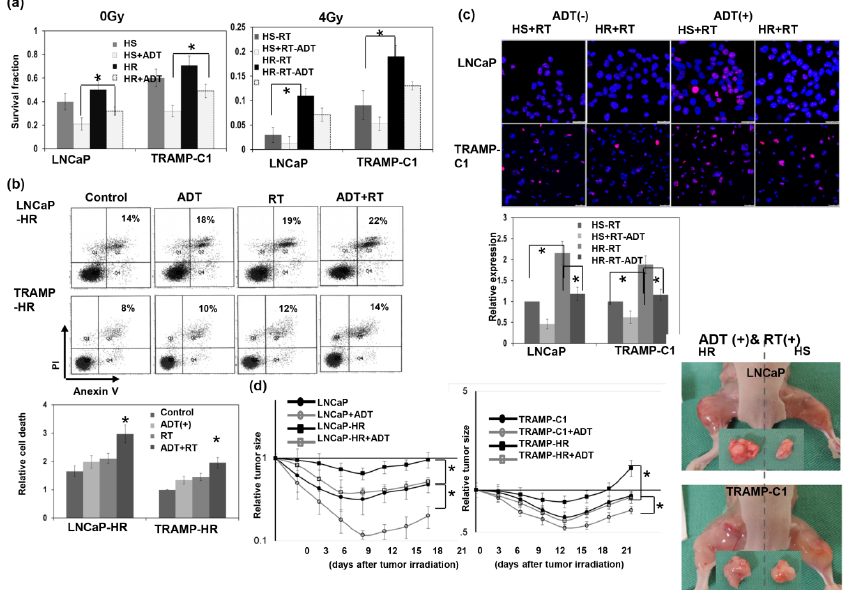
Figure 2. Treatment sensitivities of hormone-sensitive and hormone-resistant (HR) prostate cancer. ( a ) Prostate cancer (hormone-sensitive (HS) and the corresponding castration-resistant prostate cancer (CRPC)) cells were treated with ADT (10 µ M enzalutamide for 3 days before irradiation) and irradiation with 0 or 4 Gy, and survival fractions were constructed using colony-forming assay data 10 days after treatment. ( b ) The in vitro effects of treatment-induced apoptosis as evaluated by FACS with Annexin V-PI staining. The y axis represents the ratio normalized by the value of TRAMP-HR under control conditions. ( c ) DNA damage as evaluated by immunofluorescence staining with p-H2AX. The y axis represents the ratio normalized by the value of HS cells with irradiation. Scale bars: 50 µ m. ( d ) The effect of ADT on the radiosensitivity of prostate cancer (LNCaP, TRAMP-C1, and the corresponding CRPC cells), as demonstrated by tumor growth delay of the ectopic tumor after 15 Gy irradiation, and representative images 12 days after 15 Gy irradiation with or without ADT. The y axis shows the tumor volume ratio at each time point, divided by the tumor volume at irradiation. Data represent the means of experiments (three animals in one experiment, performed three times independently), * p <